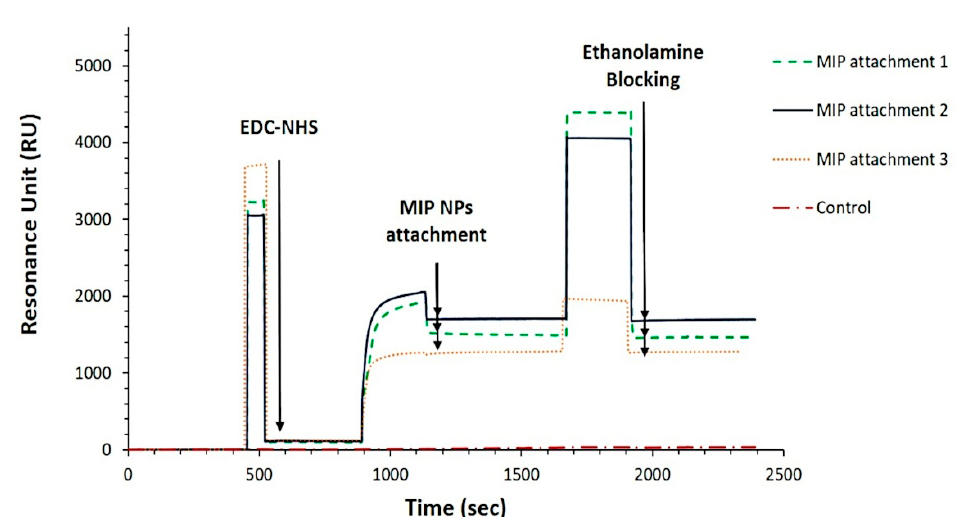
Figure 3. On-line sensorgrams showing the attachment of the nanoMIPs onto the sensor chip (triplicates). The average of the RU value achieved over three replicates was 1320 (±221).